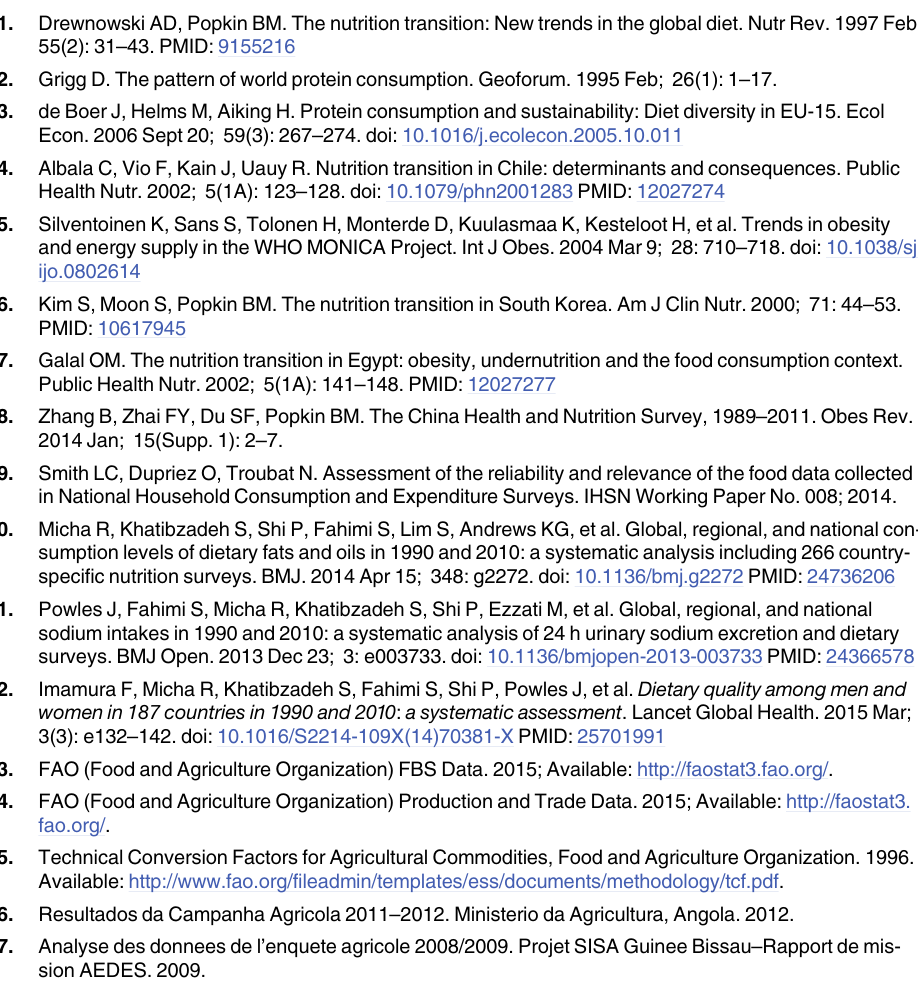
S1 Table. GENuS Foods and Associated Categories. Associated GDD food groups and non-